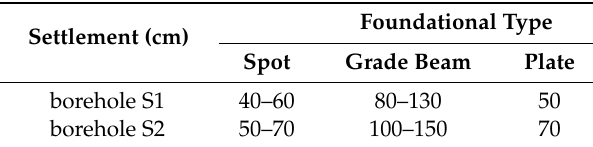
Table 4. Theoretical settlement entity and rates, estimated from borehole S1, using standard loads, collected foundation types, and geotechnical parameters derived from 3D modelling.